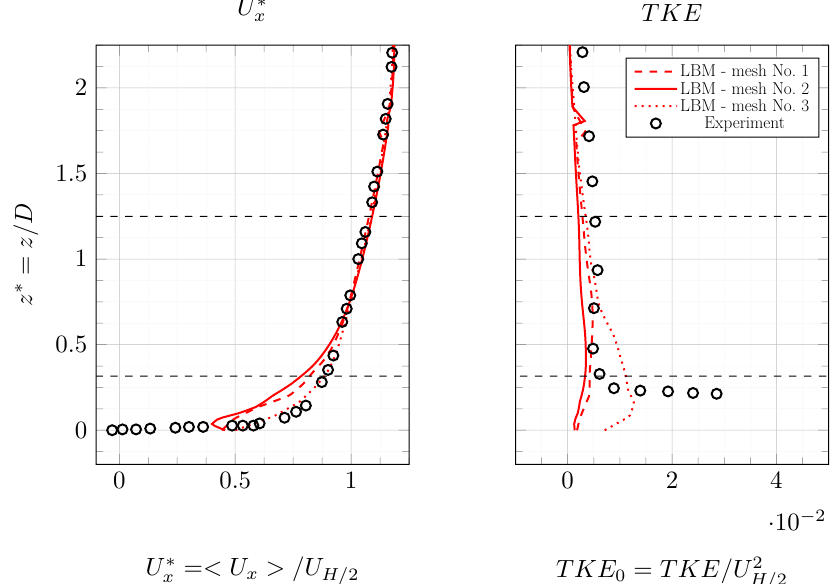
Figure 6. Average axial velocity and TKE upstream of the tidal turbine [27]: experimental data and ALM-LBM results for the three meshes. Turbine footprint is drawn in horizontal black